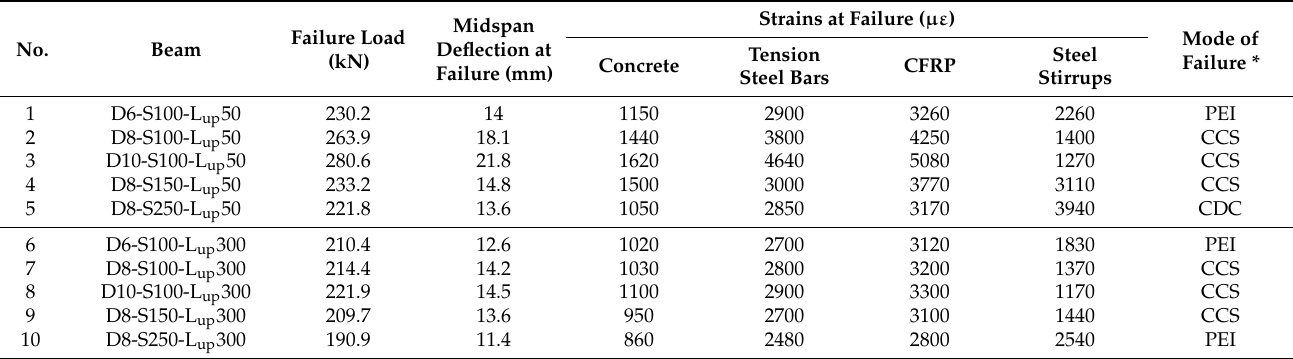
Table 3. Summary of test